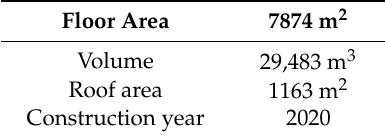
Figure 2. The office building, VTT FutureHub, in Espoo, Finland. Figure 2. The o ffi ce building, VTT FutureHub, in Espoo, Finland. Table 1. VTT FutureHub building Table 1. VTT FutureHub building characteristics.